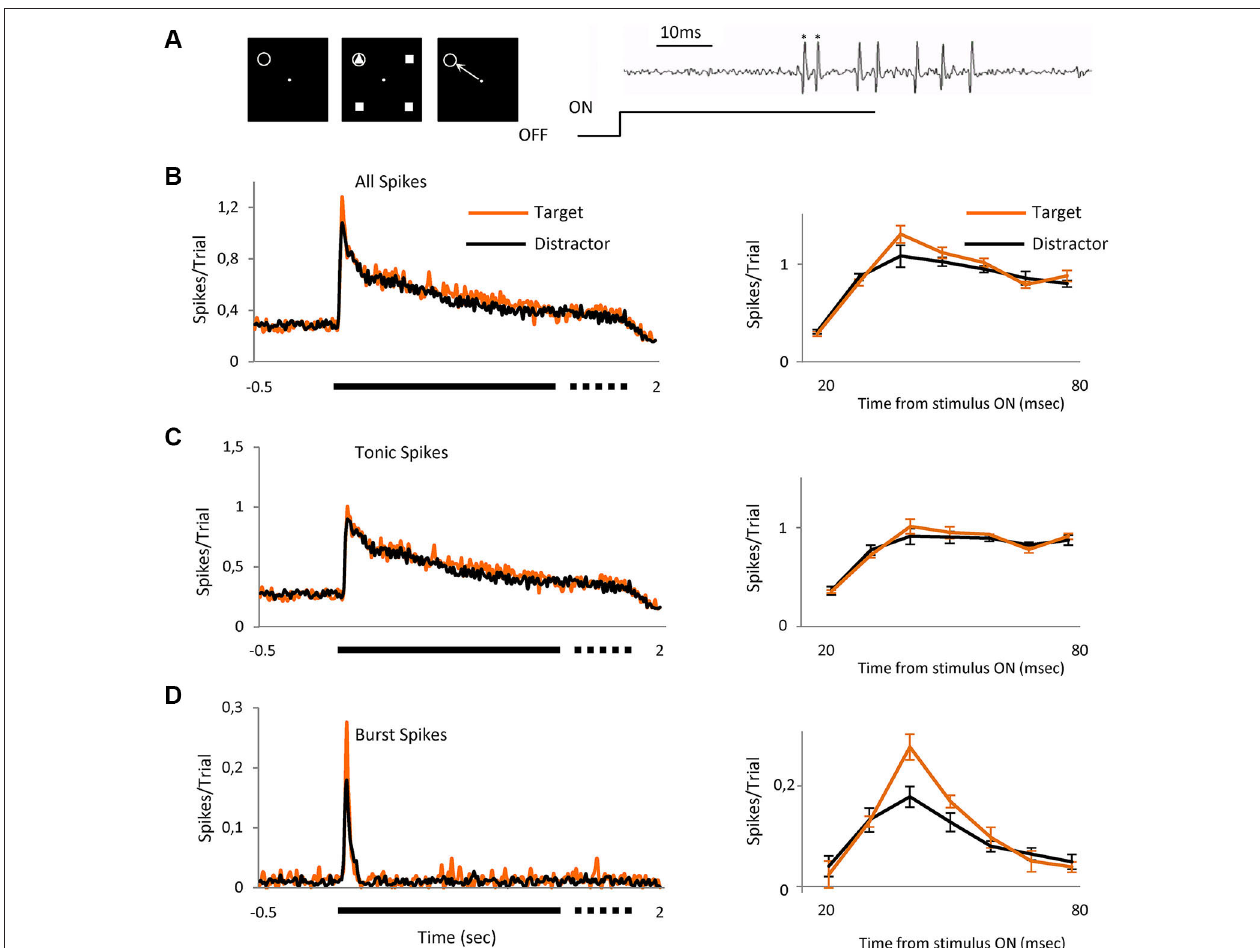
was not displayed. Right image shows an example extracellular recording showing a burst (spikes marked *) and tonic spikes (unmarked) mixed within the same recording. (B) The left peristimulus time histogram shows the averaged responses of 42 cells to presentation of the two classes of visual stimulus, right PSTH shows a detailed view of the initial part of the response (20 to 80 ms) where the differences between target and distractors are evident (mean ± SEM). (C) Represents only tonic spikes and (D) spikes in burst. Spikes/trial refers to the average number of spikes for all the trials; it allows a quick comparison between figures, independently of the number of trials. Bin size = 10